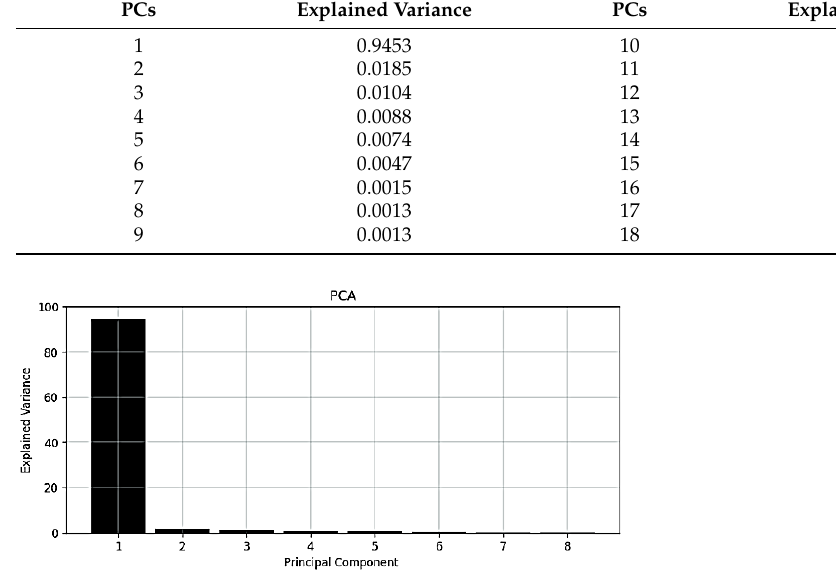
Table 9. The Degree of Variability Explained by PCs.